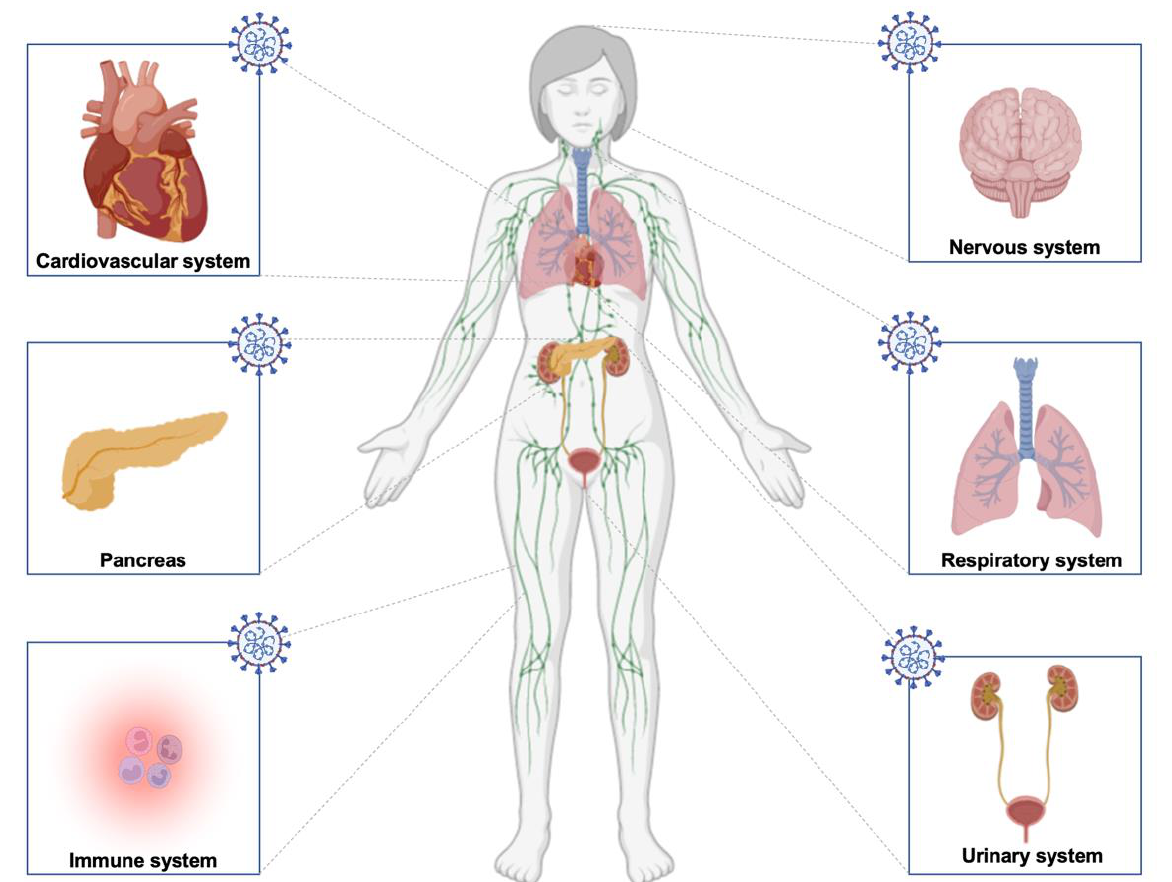
Figure 3. Schematic of different systems and organs affected by long COVID. The infection can impact the nervous, cardiovascular, urinary, immune, and respiratory systems and the pancreas in diabetes conditions.